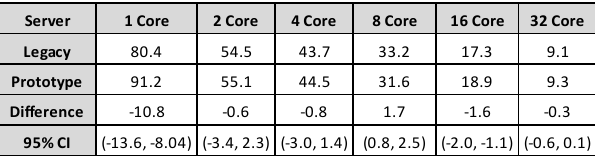
Table 6: 95% Confidence Intervals of Mean